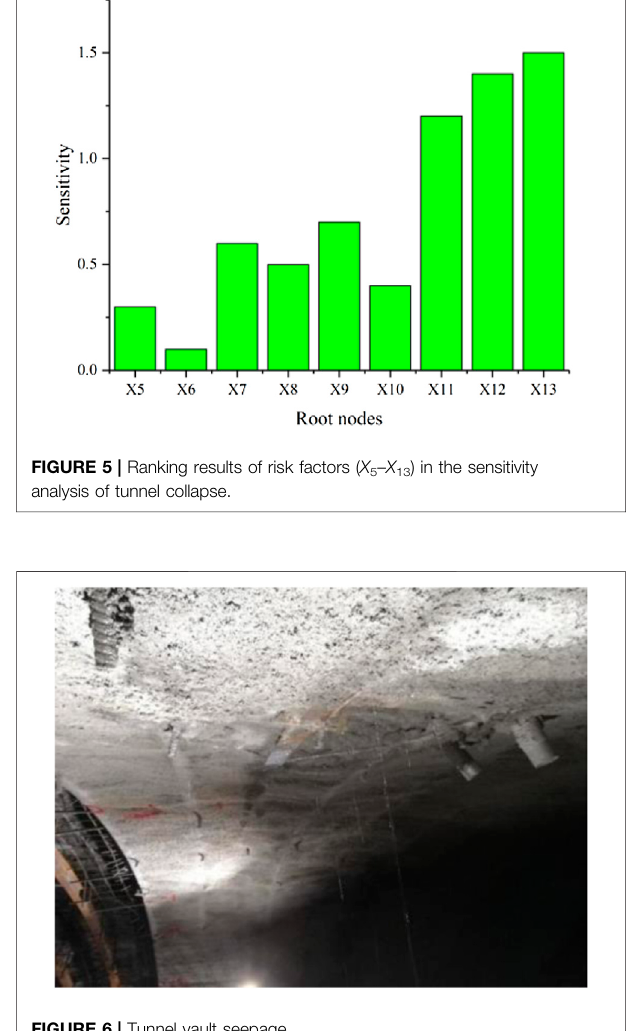
FIGURE 6 | Tunnel vault seepage.